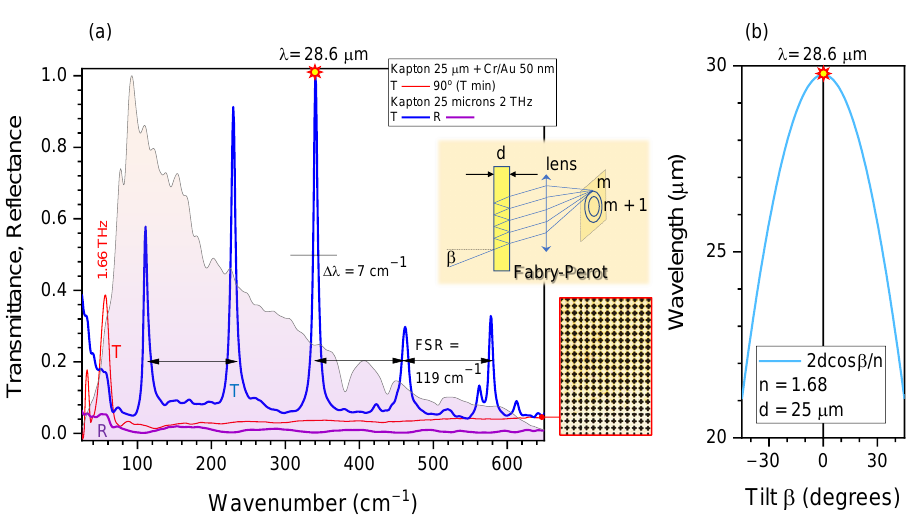
Figure 4. THz transmission and reflection studies using Kapton filters. ( a ) Transmission spectra show that metal-coated Kapton was performing equivalently to the SUS304 foil filters. Kapton with cut out crossed but without coating showed Fabry–Pérot (FP) etalon action with free spectral range FSR = 119 cm − 1 ; this was also observed with unstructured Kapton films. The background spectra is synchrotron radiation (detected without sample, filter nor polariser). Optical image of the metal-coated filter is shown on the right-side. The inset shows schematics of the FP etalon action. ( b ) Tunability of FP etalon by tilt angle β for the d = 25 µ m thick Kapton film with n = 1.68 refractive index. The condition of FP maxima is 2 d cos β = m λ